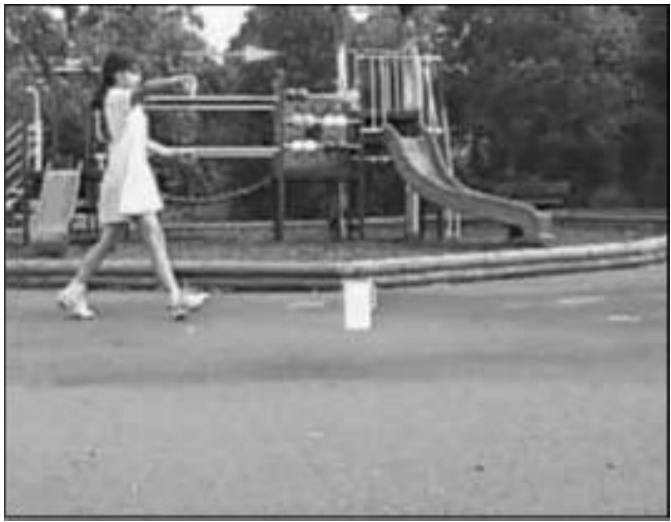
Figure 2. Image of girl with a ball (Kearney & Wright,